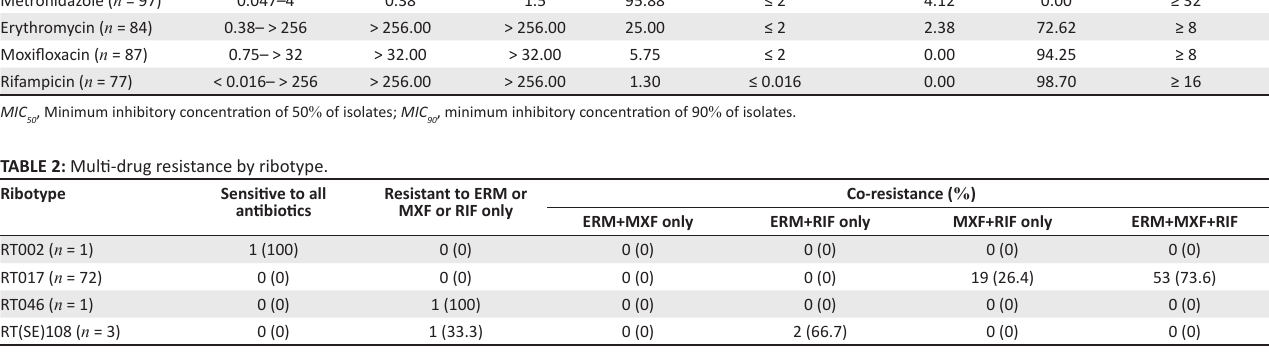
TABLE 1: Antibiotic susceptibility data for isolates.